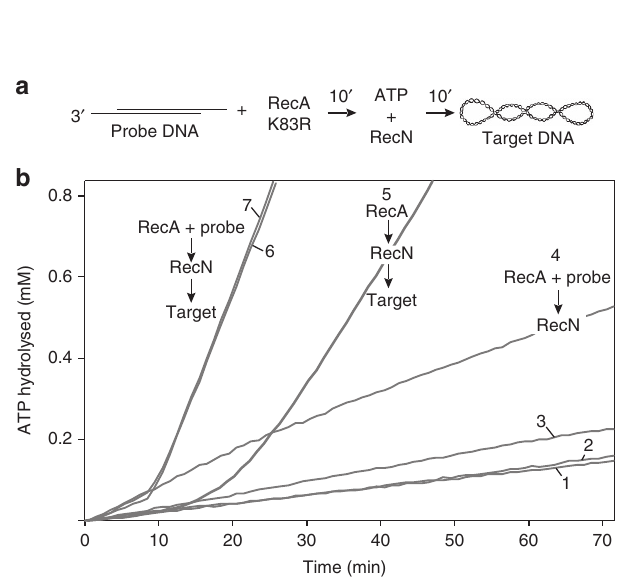
(Fig. 4). All averages and s.d.’s were calculated from 4 independent trials except that data for reaction 5 were calculated from 10 independent trials.